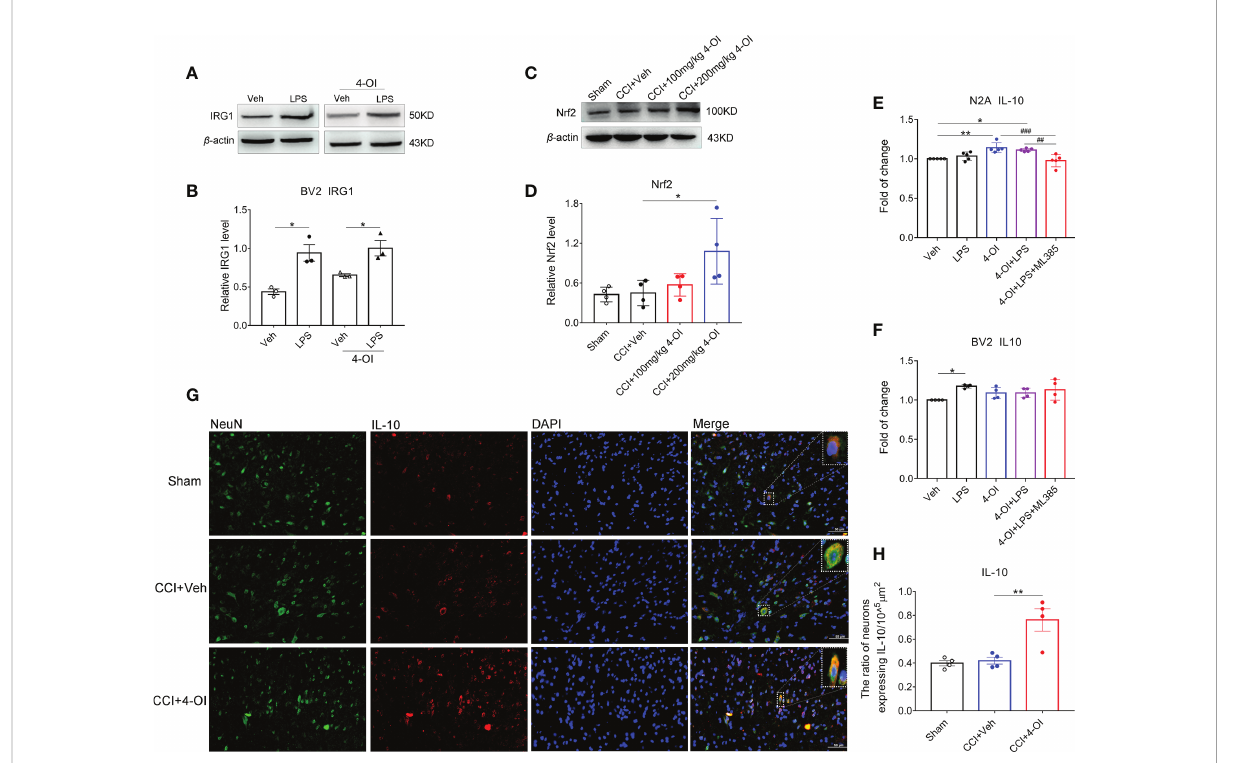
FIGURE 9 Itaconate promoted the neuronal expression of IL-10 by activation of Nrf2. The representative image (A) and statistical analysis (B) of IRG1 protein level in BV2 cells under LPS and 4-OI treatment. Data are presented as mean ± SEM. * p <0.05 vs. Veh followed by One-way ANOVA with Dunnett ’ s multiple comparisons test (n = 3). The representative image (C) and statistical analysis (D) of Nrf2 protein level in the ipsilateral spinal cord at 2 h after the intraperitoneal injection of 4-OI in male CCI mice at 14 th -day post-injury. Data are presented as mean ± SEM. * p <0.05 vs. CCI + Veh followed by One-way ANOVA with Dunnett ’ s multiple comparisons test (n = 4). The release of IL-10 after the treatment of 4-OI, LPS, and ML385 in the culture medium of N2A cells (E) and BV2 cells (F) was detected by ELISA. ** p <0.01, * p <0.05 vs. Veh, ### p <0.001, ## p <0.01 vs. 4-OI + LPS + ML385 followed by One-way ANOVA with Dunnett ’ s multiple comparisons test (n = 4-5). (G) The colocalization of neuronal marker NeuN and IL-10 in the spinal dorsal horn of male CCI mice. (H) Statistical analysis of the proportion of spinal neurons expressing IL-10. Data are presented as mean ± SEM. ** p <0.01 vs. CCI + Veh followed by One-way ANOVA with Dunnett ’ s multiple comparisons test (n =